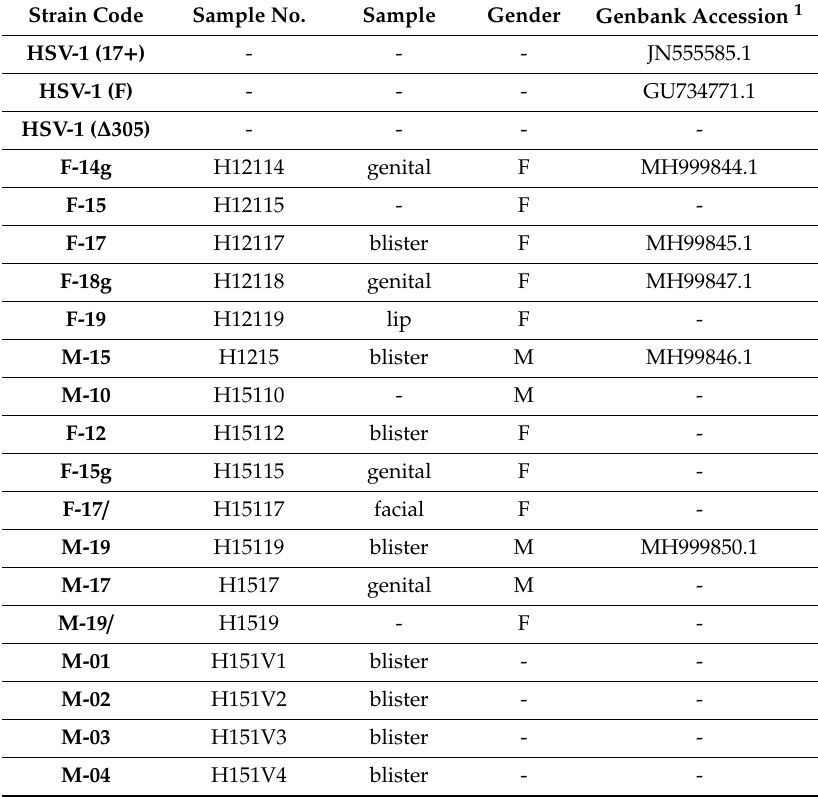
Table 1. HSV-1 strains used in this study. Strain Code Sample